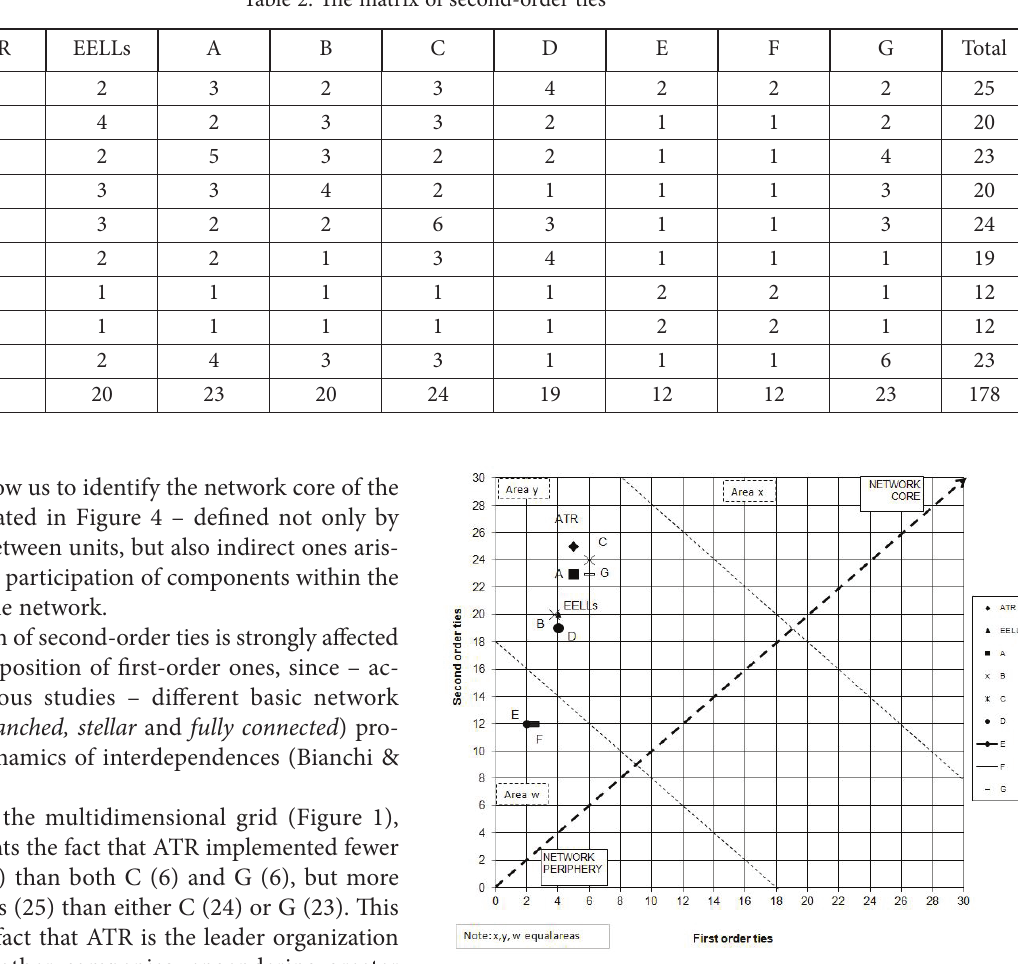
Figure 4. The location of ATR network units in the grid of analysis Moreover, the EELLs’ position is quite far from the network core. This confirms the shift of EELLs to the periphery, which was due to the network evolution that emerged in the local transport system over the last decade, driven by national